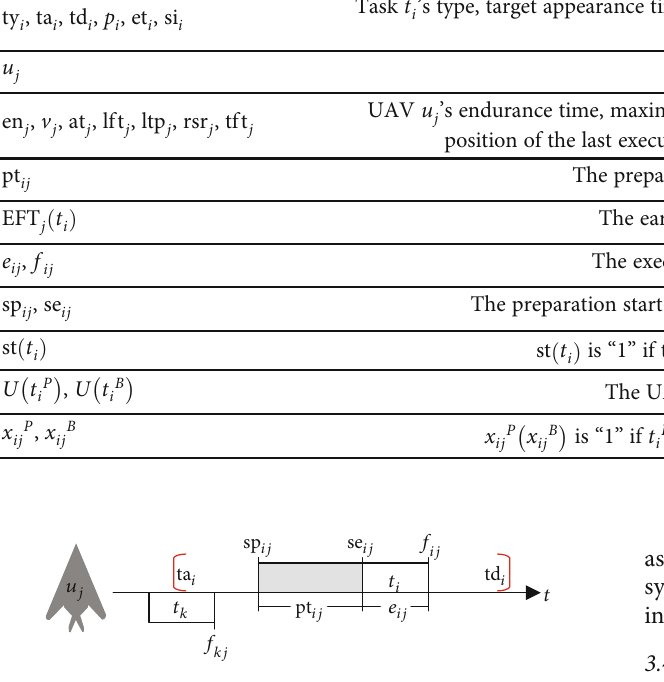
Figure 1: The task assigning parameters.